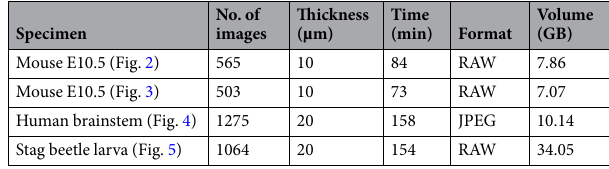
Table 1. Acquisition time and data